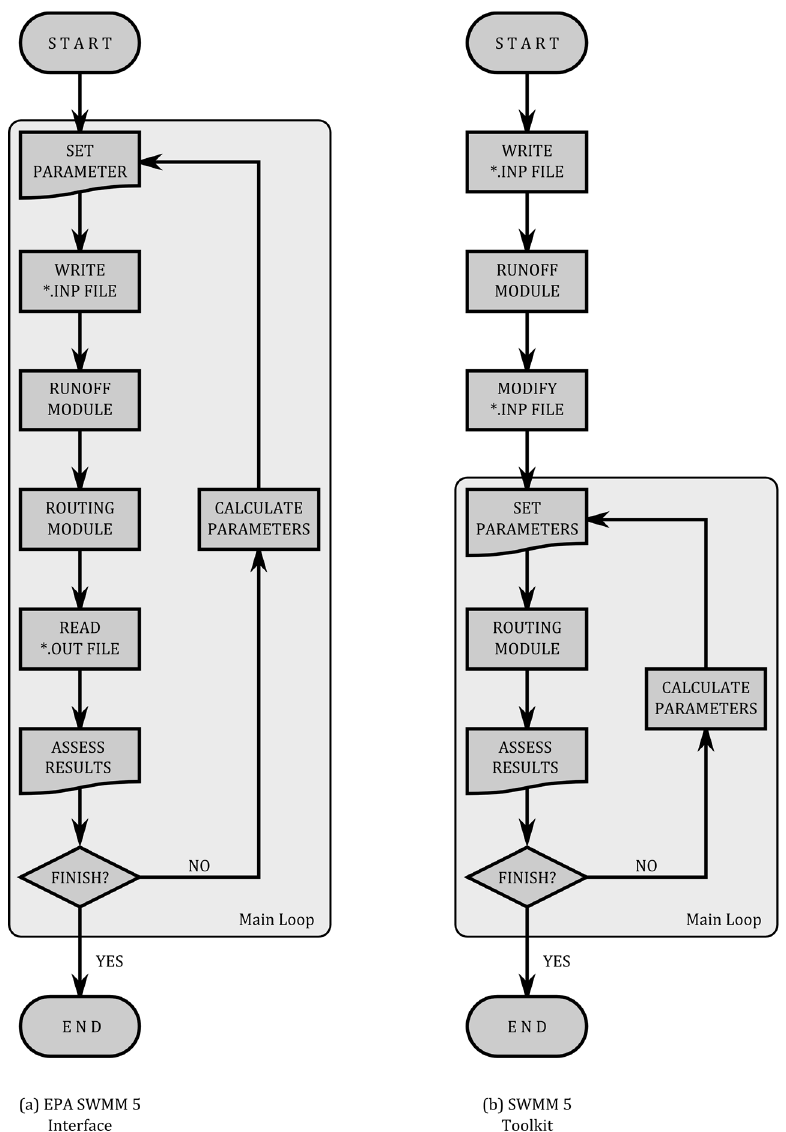
Figure 2. Comparison scheme of optimization algorithm performance using EPA SWMM 5 ( a ) and the Toolkit ( b ).